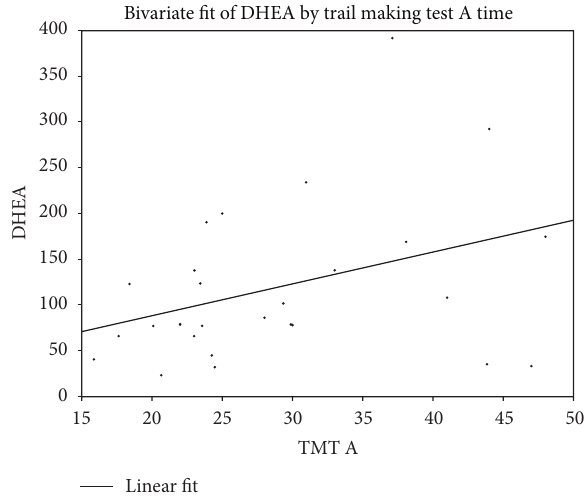
Figure 2: Relationship between morning DHEA (pg/mL) and performance on Trail Making Test Part